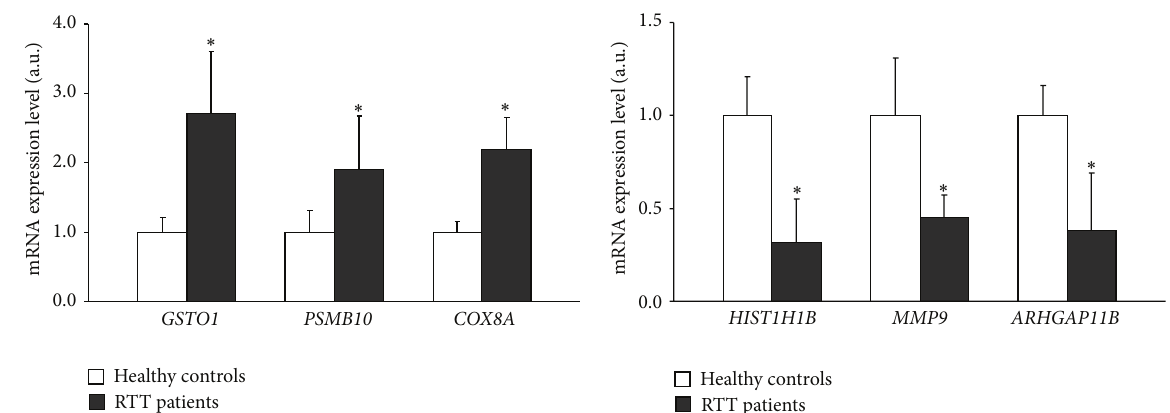
Figure 2: Validation of relative gene expression levels for selected genes using RT-qPCRin PBMC from 12 RTT patients and 7 controls. Results arethemeans ± SEMofthreeindependentexperiments,eachanalysedintriplicate. ∗ 𝑃 value < 0.001versuscontrol(one-wayANOVAfollowed by Bonferroni’s